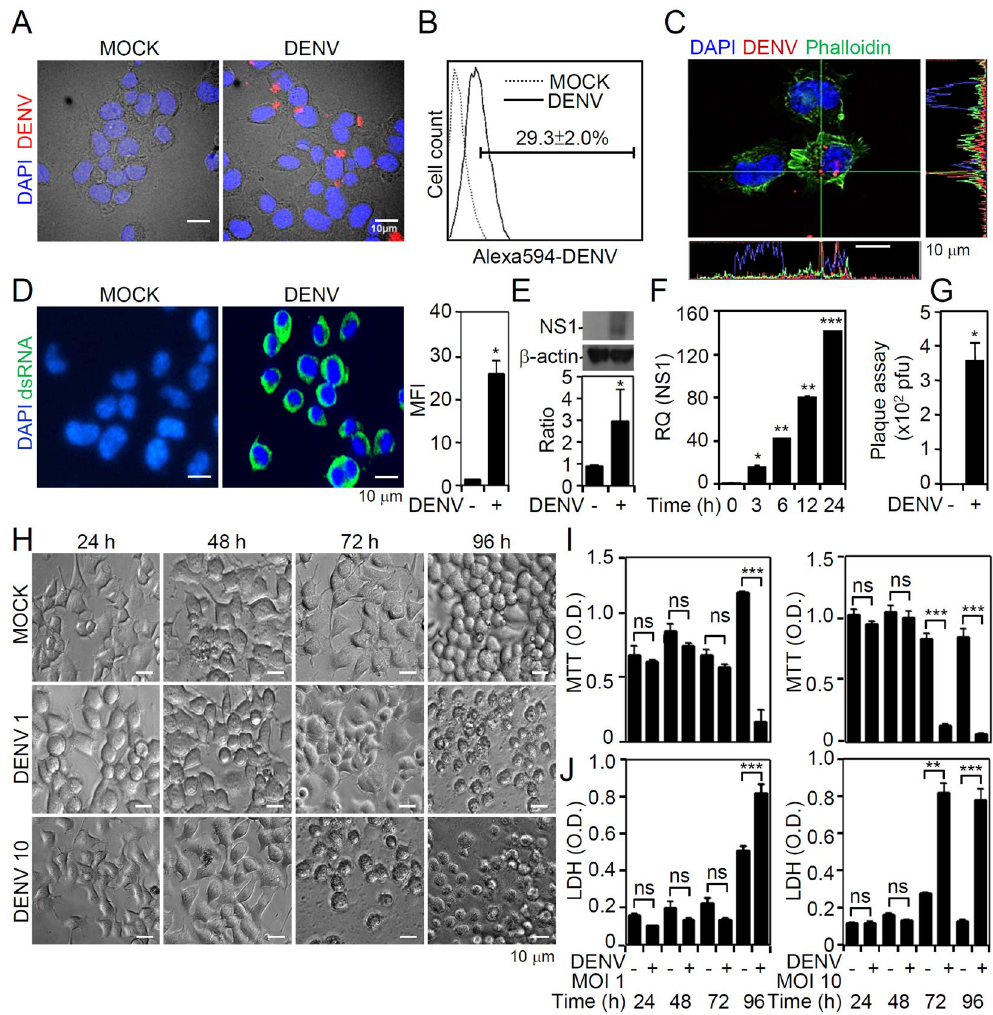
Figure 1. Dengue virus (DENV) serotype 2 PL046 (DENV2) causes infection, including viral entry, double- stranded (ds)RNA replication, viral protein expression, virus release, and neurotoxicity, in the Neuro-2a murine neuronal cell line. ( A ) Fluorescence, ( B ) flow cytometric, and ( C ) three-dimensional confocal image analyses showed Neuro-2a cells carrying Alexa-594 labeled ( red ) DENV2 at 2 h post-infection. Phalloidin ( green ) staining indicates actin. ( D ) Immunocytochemistry and the relative mean fluorescence intensity ( MFI ) of viral dsRNA ( green ) at 24 h post-infection. ( E ) The Western blot analysis showed viral nonstructural protein1 ( NS1 ) expression at 24 h post-infection. The relative ratio to β -actin is shown. ( F ) A qPCR showed the time-kinetic mRNA expression of NS1, and ( G ) plaque assays showed the level of viral replication at 24 h post-infection. ( H ) Cell morphology, ( I ) MTT, and ( J ) lactate dehydrogenase (LDH) assays showed cell growth, viability, and cytotoxicity, respectively, in DENV-infected cells for the indicated times and different multiplicities of infection (MOIs). For all images and blots, representative data were selectively obtained from three individual experiments. DAPI staining indicates nuclei ( blue ). For the flow cytometric analysis, the percentage of positive cells is shown. All quantitative data are shown as the mean ± SD of three independent experiments. * p < 0.05, ** p < 0.01, and *** p < 0.001. ns, not